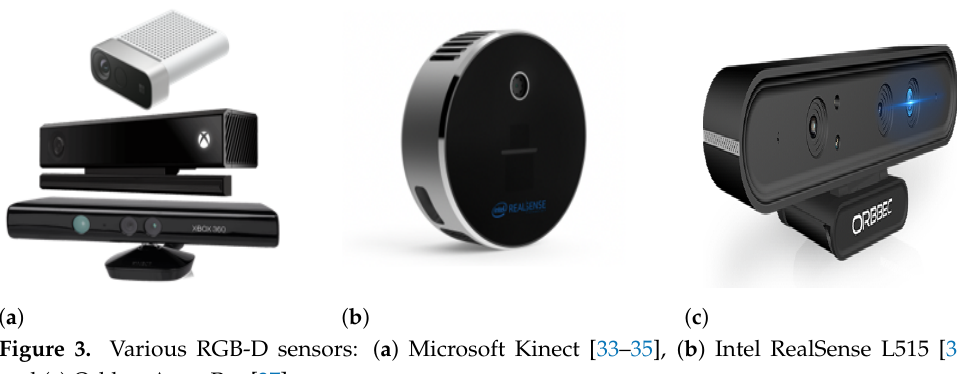
Figure 3. Various RGB-D sensors: ( a ) Microsoft Kinect [33–35], ( b ) Intel RealSense L515 [36], and ( c ) Orbbec Astra Pro